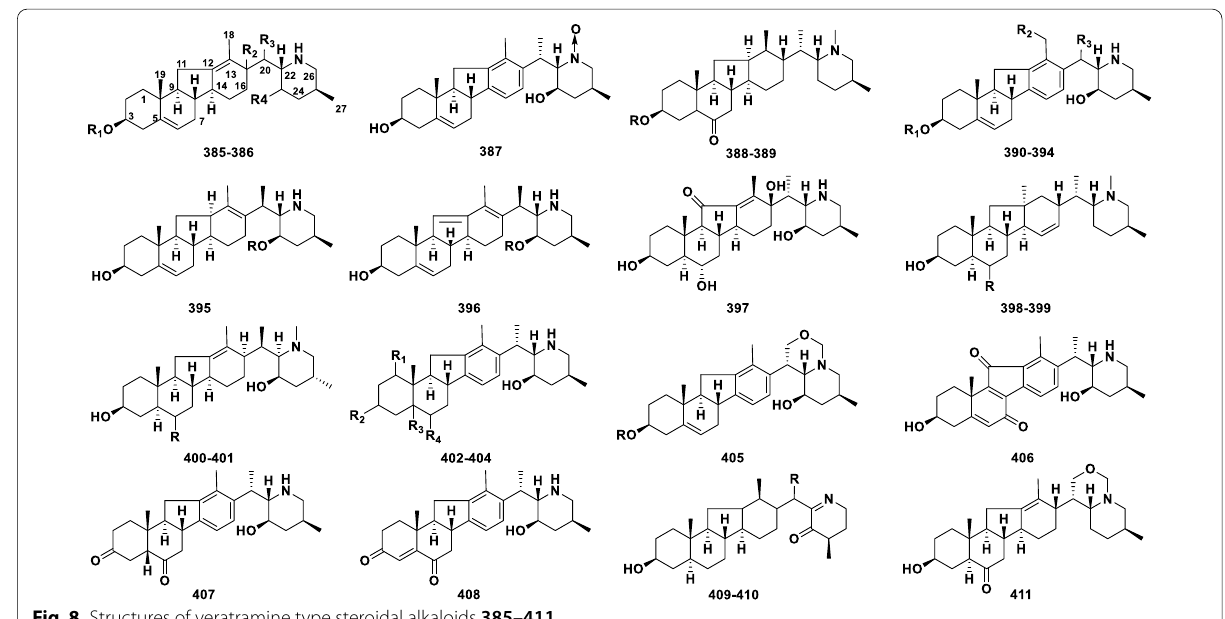
Fig. 8 Structures of veratramine type steroidal alkaloids